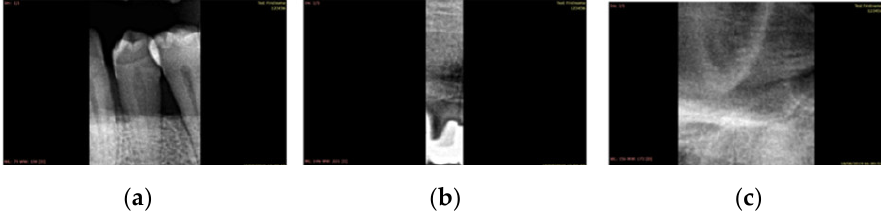
Figure 4. Anomalies in bounding boxes: ( a ) Several teeth in the same bounding box; ( b ) Tooth incorrectly delimited; ( c ) Indistinguishable.